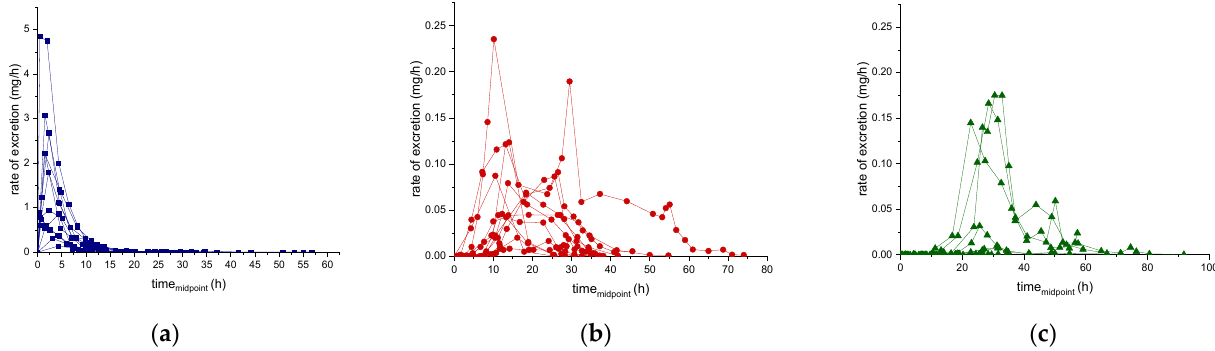
Figure 3. Urinary excretion profile (rate of excretion-midpoint time curve) of ecdysterone ( a ), 14-deoxy-ecdysterone ( b ), and 14-deoxy-poststerone ( c ), following a single-dose administration of 50 mg of pure ecdysterone in humans ( n = 12).